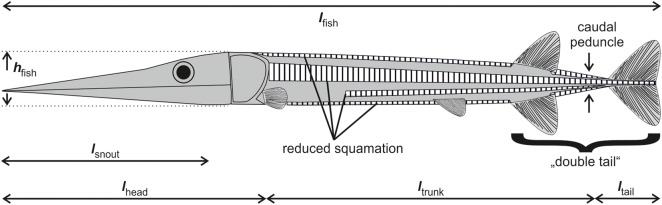
General morphology of Saurichthys with some morphometric distances.
hfish, maximal height excluding fins; lfish, total body length; lsnout, maximal length of the mouth gape; lhead, head length; ltrunk, trunk length from the hind margin of the operculum to the narrowest point of the caudal peduncle; ltail, length from the narrowest point of the caudal peduncle to the hind margin of the caudal fin. The dorsal, anal and caudal fins form the ‘double tail’ sensu
Weihs, 1989.